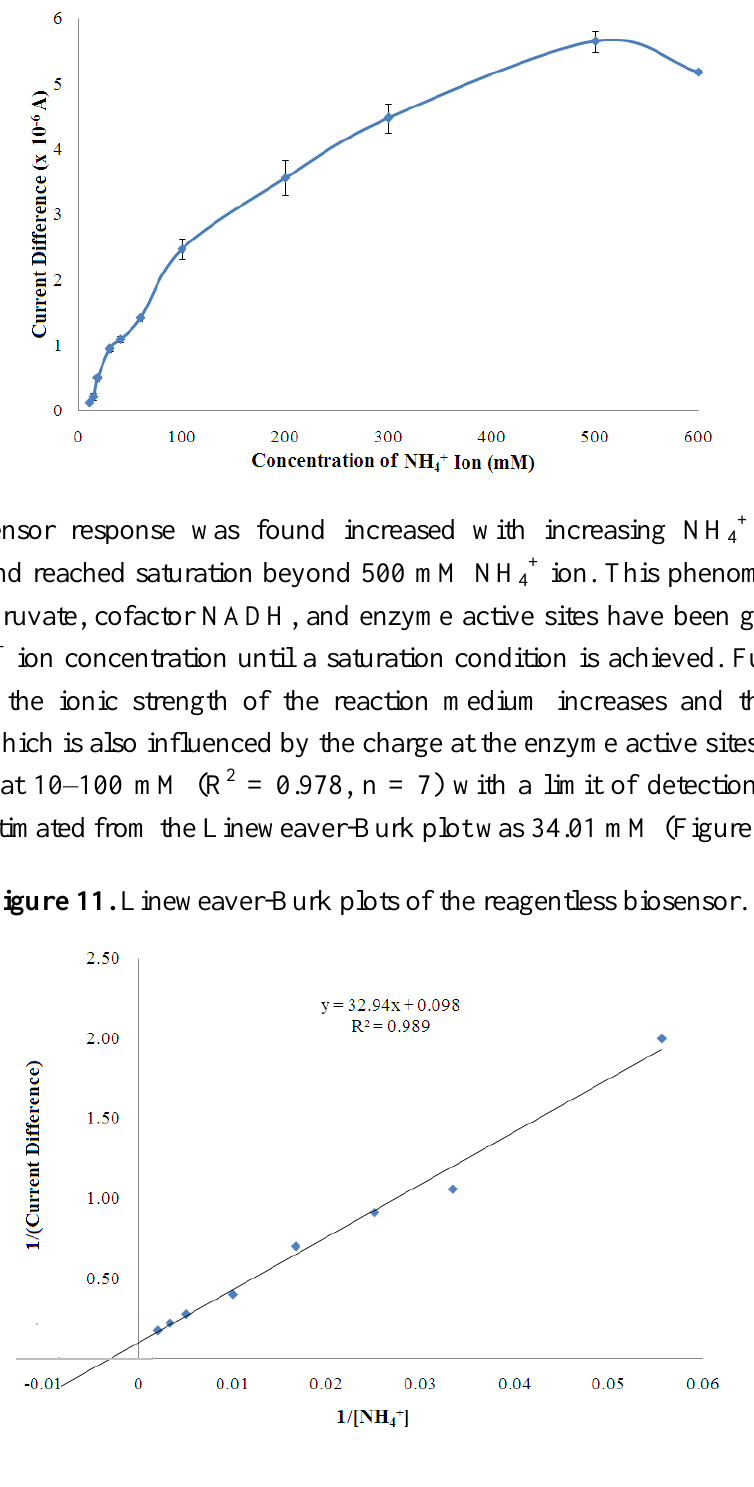
Figure 10. The response of the biosensor towards different NH 4+ ion concentration in the range of 10–600 mM at pH 7 (n = 3).